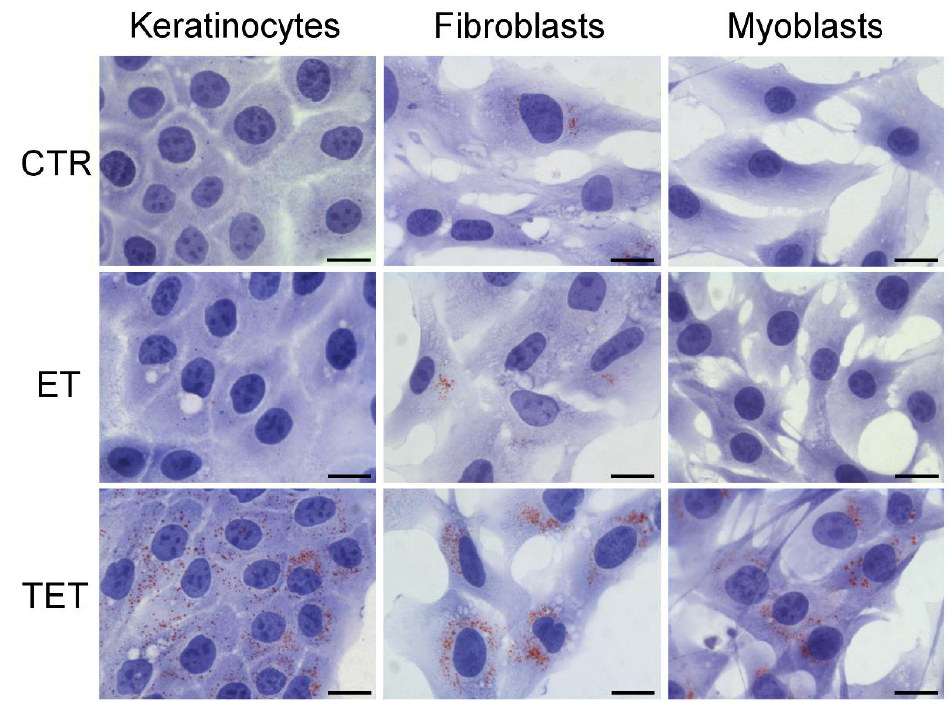
Figure 6. Bright-field micrographs of keratinocytes, fibroblasts and myoblasts after 24 h incubation with ET or TET; CTR are control (untreated) cells. Oil Red O-staining for neutral lipids, hematoxylin counterstaining. Note the marked increase in lipid droplets in TET-treated cells. Bars 20 μm.